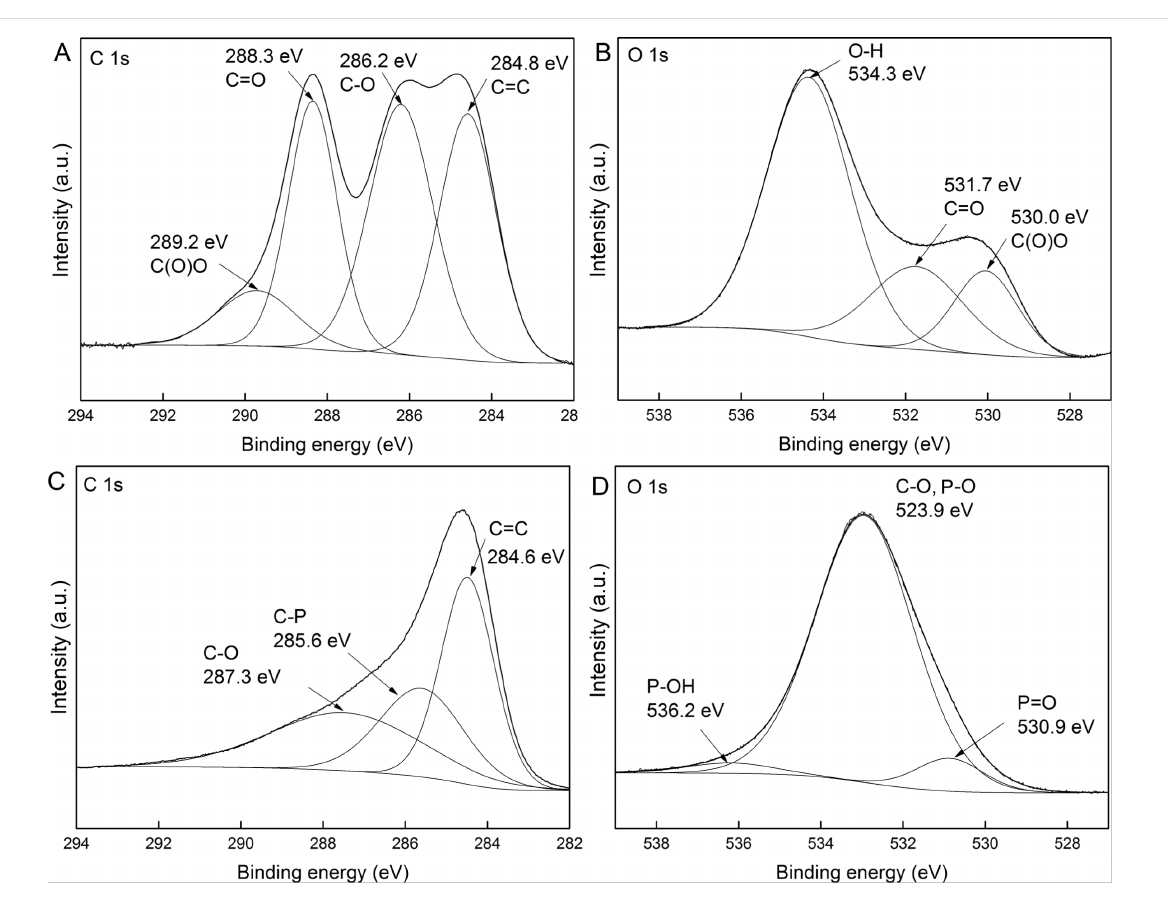
Figure 7: High-resolution XPS spectra with curve fittings for the C 1s and O 1s for GO (A and B) and GO-P (C and D).